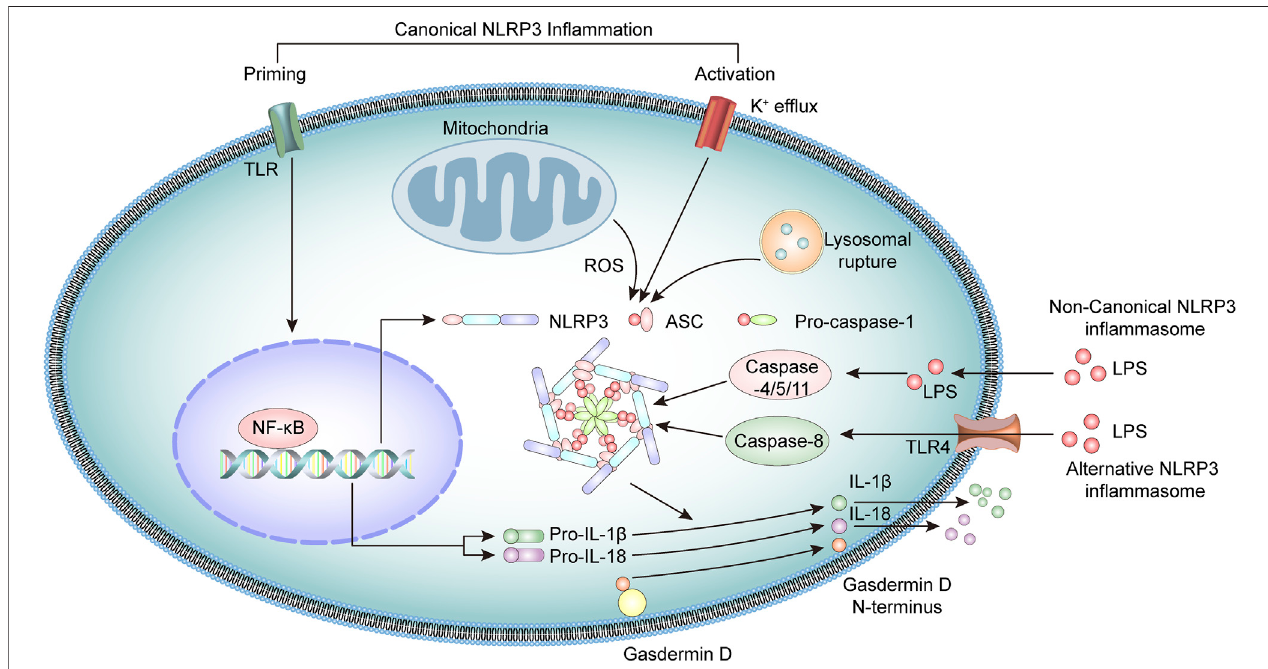
FIGURE 1 | Overview of the molecular mechanisms of the NLRP3 in fl ammasome pathway.